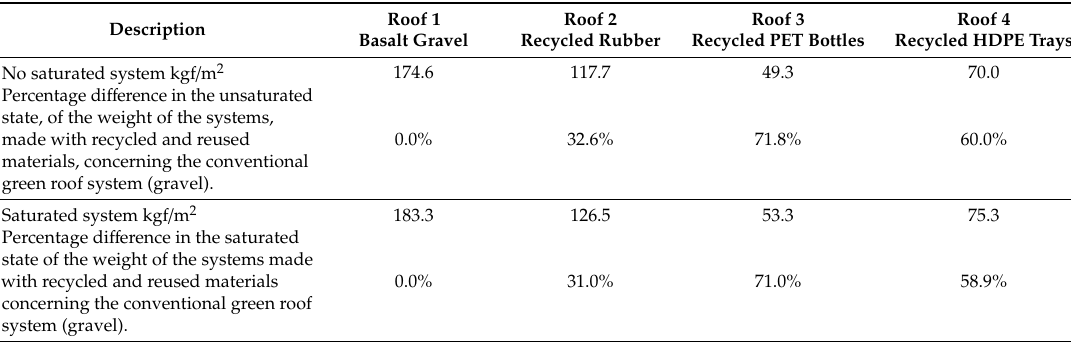
Table 4. Weight per area for each roofing system proposed. Value for 1 m 2 .